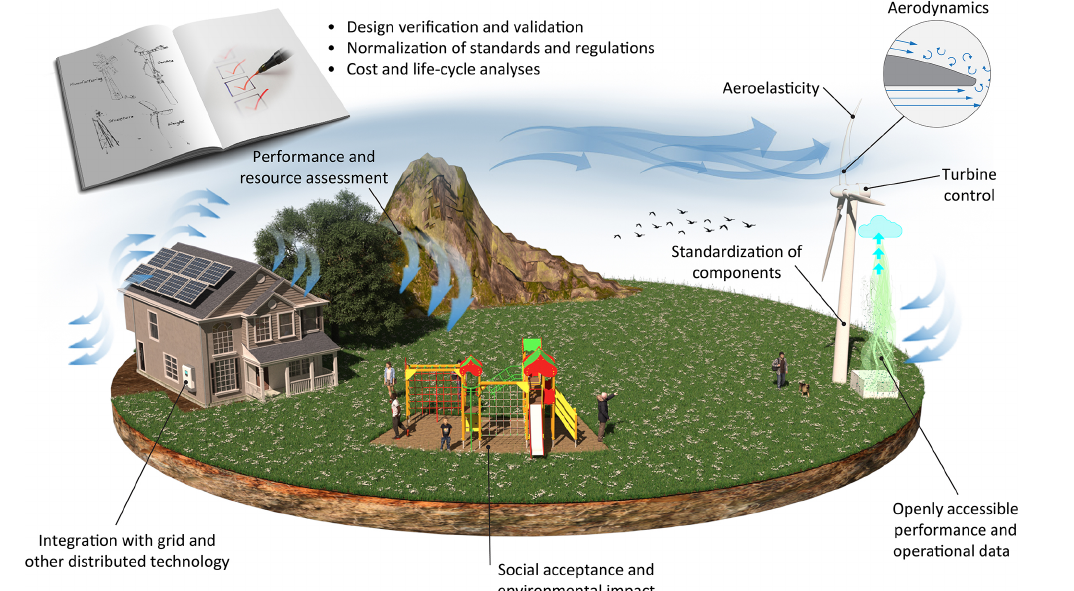
Figure 14. Visual synopsis on how the key enablers identified in this study may help tackle the five grand challenges for SWT technology.